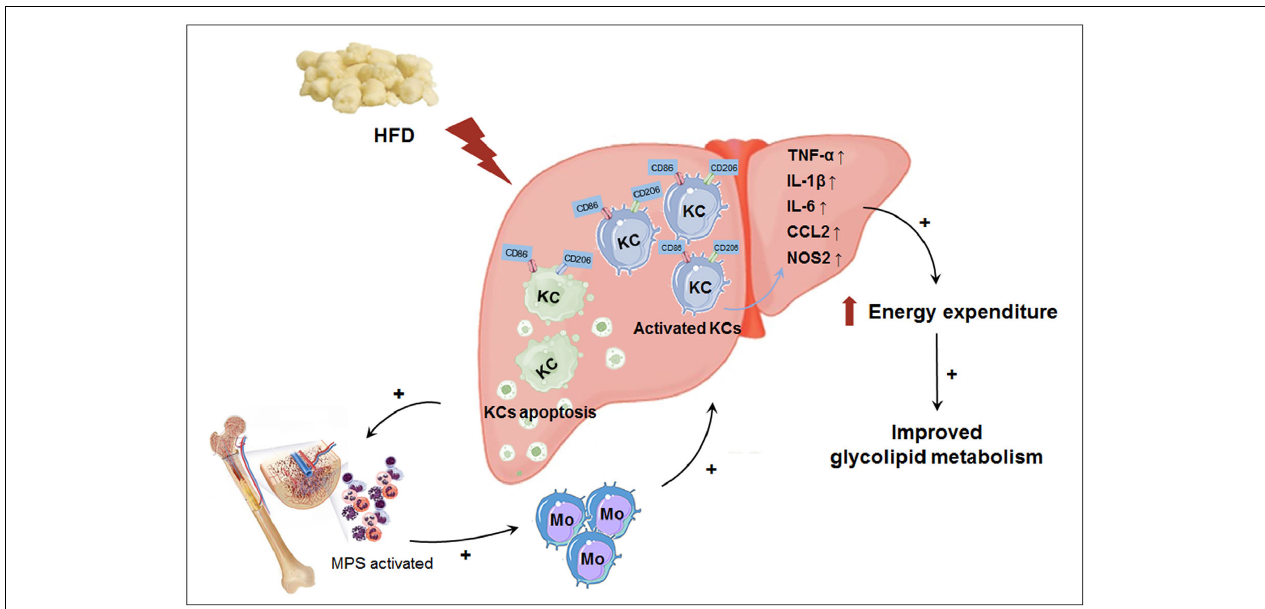
FIGURE 9 | Macrophage LAMTOR1 deficiency prevents dietary obesity and insulin resistance through inflammation-induced energy expenditure. Kupffer cells presented as CD86 + CD206 + . Macrophage LAMTOR1 deficiency led to a spontaneous hepatic aggregation/accumulation of Kupffer cells. While fed with HFD, more LAMTOR1-null Kupffer cells located around the epithelial cells in the central vein area, as well as the portal area because of the decreased lipid tolerance. The bone marrow, with enhanced proliferation of MPS induced by apoptosis of Kupffer cells, was the main source of macrophages accumulated in the liver. Meanwhile, overactivated Kupffer cells induced hyperinflammatory state, indicated by increased cytokines including TNF- α , IL-1 β , and IL-6, resulted in elevated energy expenditure and improved glycolipid metabolism. CCL2, C-C motif chemokine ligand 2; HFD, high-fat diet; IL, Interleukin; KC, Kupffer cell; KO, myeloid-specific knockout mice; Mo, monocyte; MPS, mononuclear phagocytic system; NOS2, nitric oxide synthase 2; TNF- α , tumor necrosis factor α ; WT,